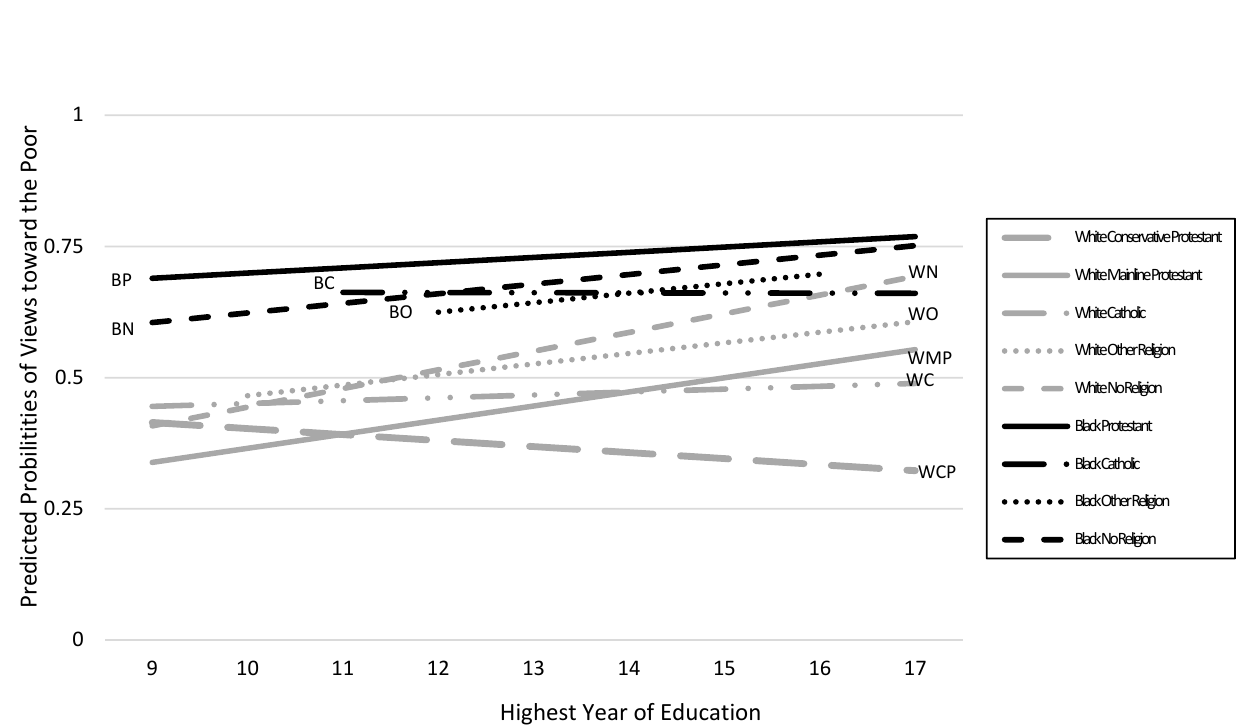
Figure A3. Views toward the poor by race, religion, and education, Pew 2014 Religious Landscape Survey.